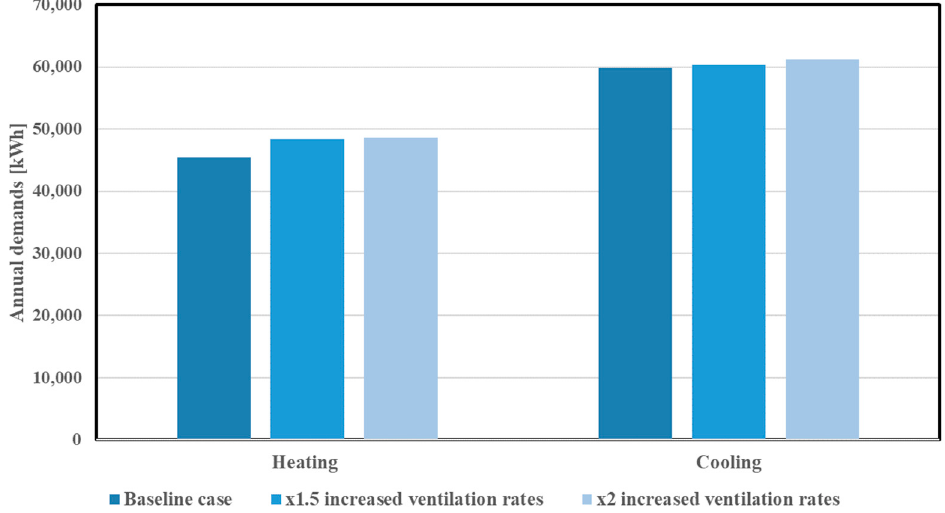
Figure 9. Annual energy demands for heating and cooling in the current building and increased ventilation rate cases.